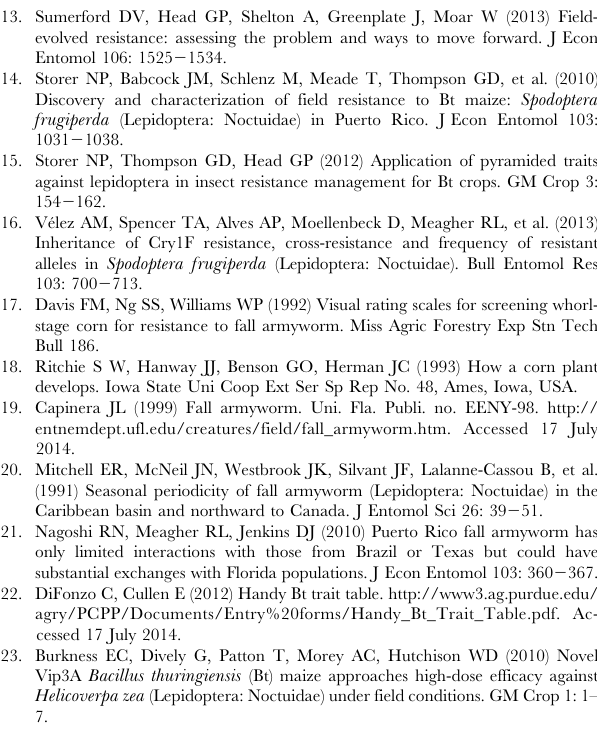
Table S8 Larval survivorship (%) of potential positive families of Spodoptera frugiperda on leaf tissue of Cry1F maize plants. Table S9 Baseline survival (mean ± SEM) of Cry1F- susceptible (SS-FL), -resistant (RR), and -heterozygous (RS) genotypes of Spodoptera frugiperda on leaf tissue of HX1 and non-Bt (NBt) maize plants. Table S10 Expected frequency of genotypes of in the F 2 progeny of a two-parent family of Spodoptera frugi- perda. Table S11 Six different parental (P 1 ) crosses of two- parent families and the related frequencies and genetic